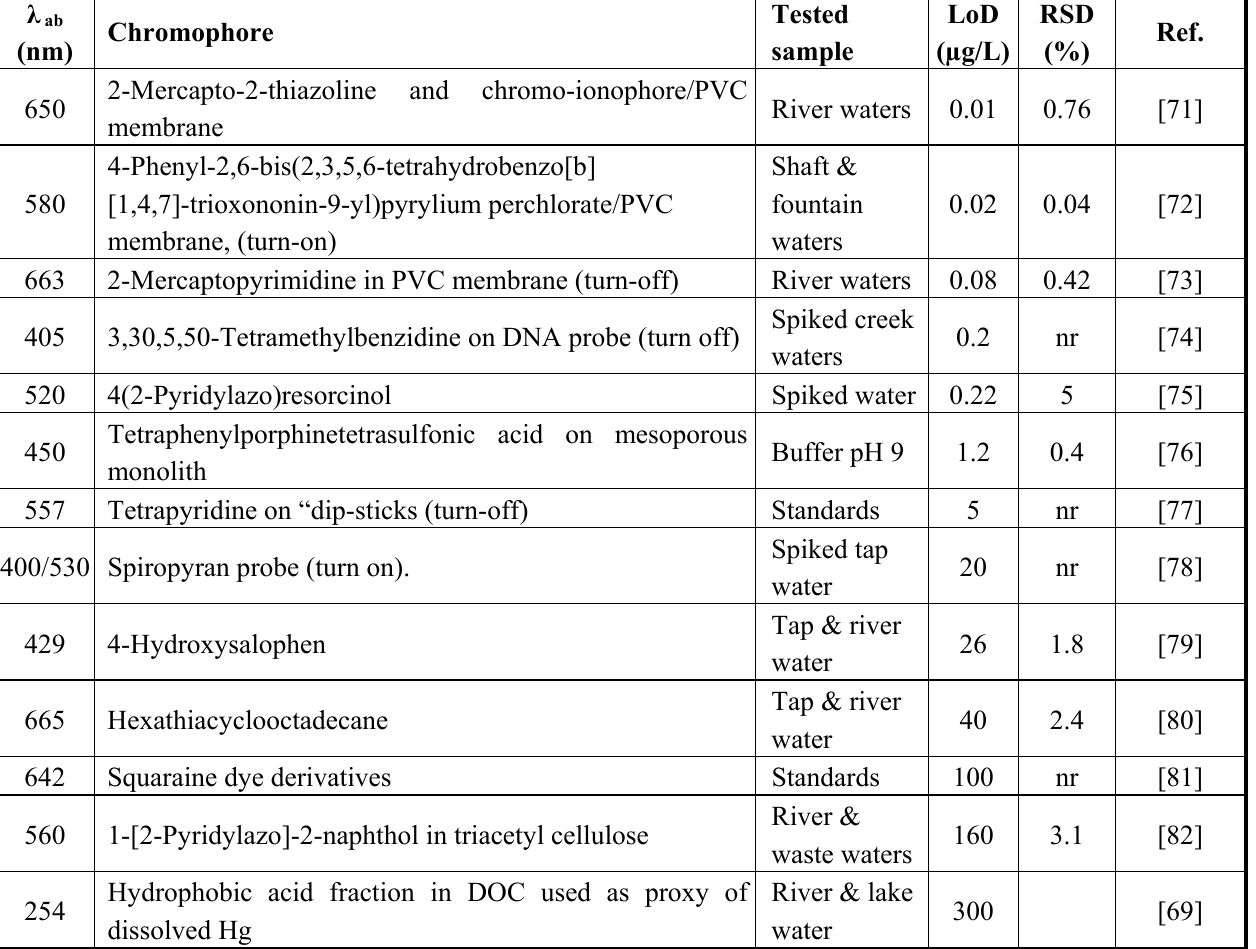
Table 4. Analytical characteristics of colorimetric sensors for mercury determination in water, published between 2007 and